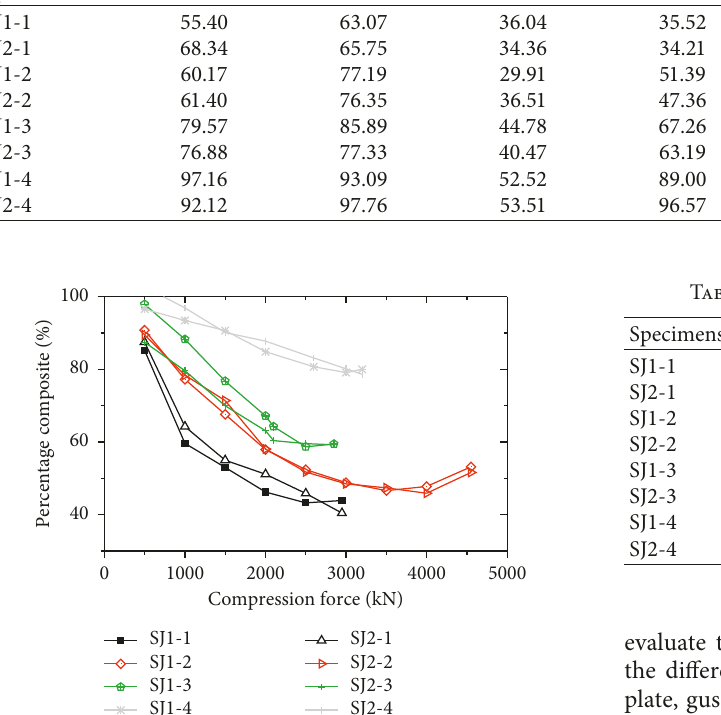
Figure 17: The percentage of composite action.